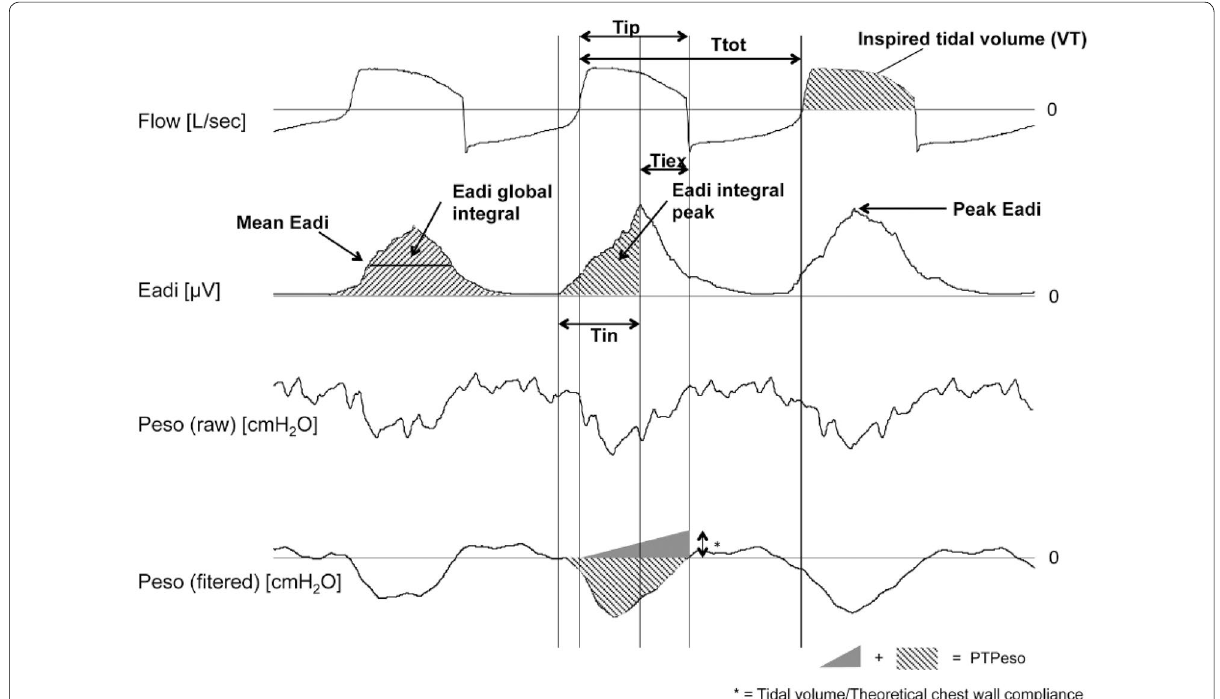
Fig. 2 Illustration of the measurements performed offline from the recorded curves (example of assisted ventilation). Tip: Pneumatic inspiratory time, Ttot: Total duration of a respiratory cycle, Tin: neural inspiratory time or time between initial increase in Eadi signal and peak Eadi, Tiex: time delay between maximal Eadi value and end of inspiratory flow. Peak Eadi: maximal Eadi value during one breath, Mean Eadi: mean Eadi value during Eadi increase related to inspiration, Eadi global integral: area under the curve (integral) of the global Eadi signal, Eadi integral peak: area under the curve of Eadi signal censured at the peak, PTPeso: Esophageal pressure–time